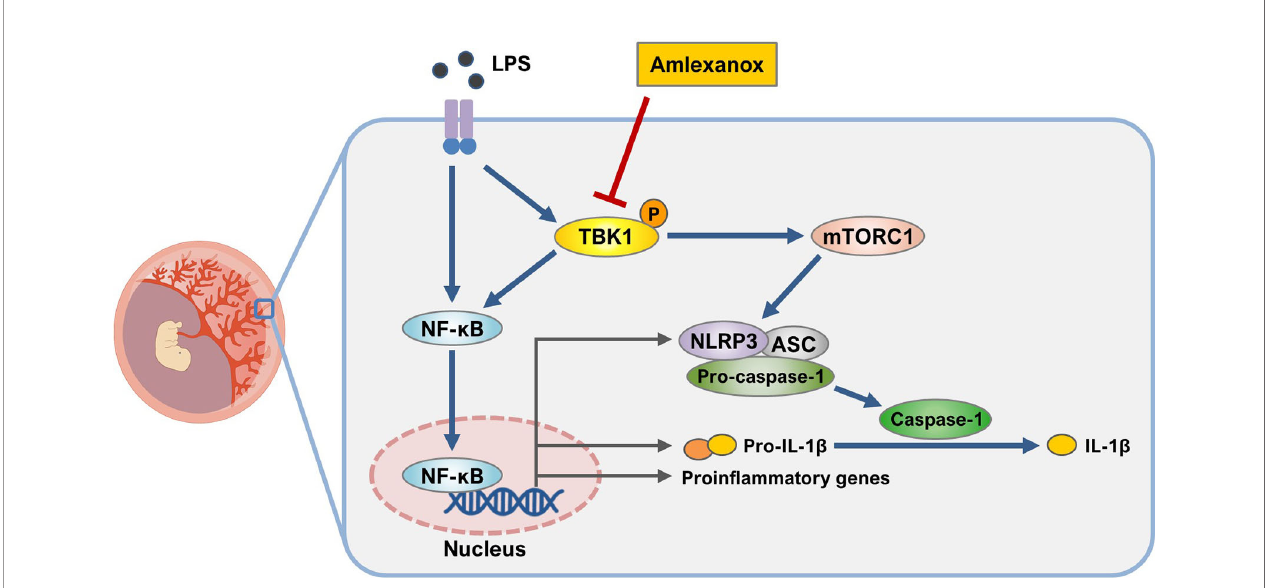
FIGURE 8 | Schematic diagram of the role of TBK1 in trophoblasts upon exposure to LPS. Inhibition of TBK1 by amlexanox not only suppresses LPS-induced NLRP3 in fl ammasome activation but also attenuates in fl ammatory response by inhibiting mTORC1